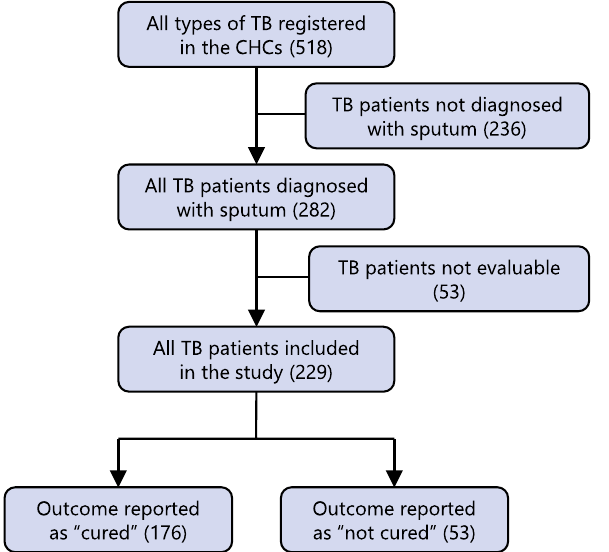
Table 1: Baseline characteristic of